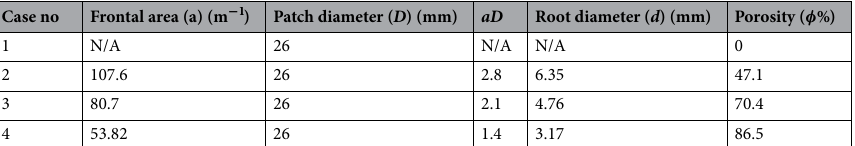
Table 1. Experiment cases with geometrical parameters. a is frontal area per unit volume and is defined as a = 1